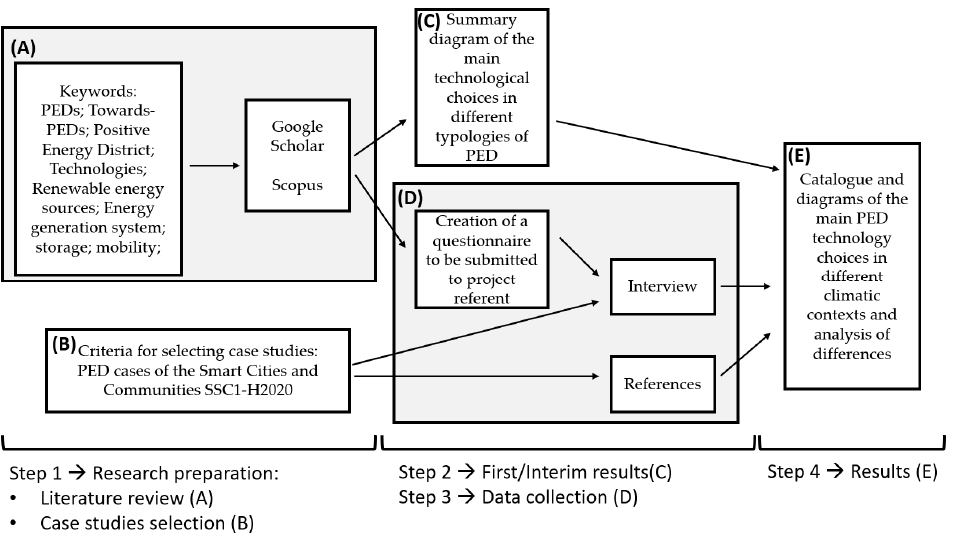
Figure 4. Implemented method in this study.